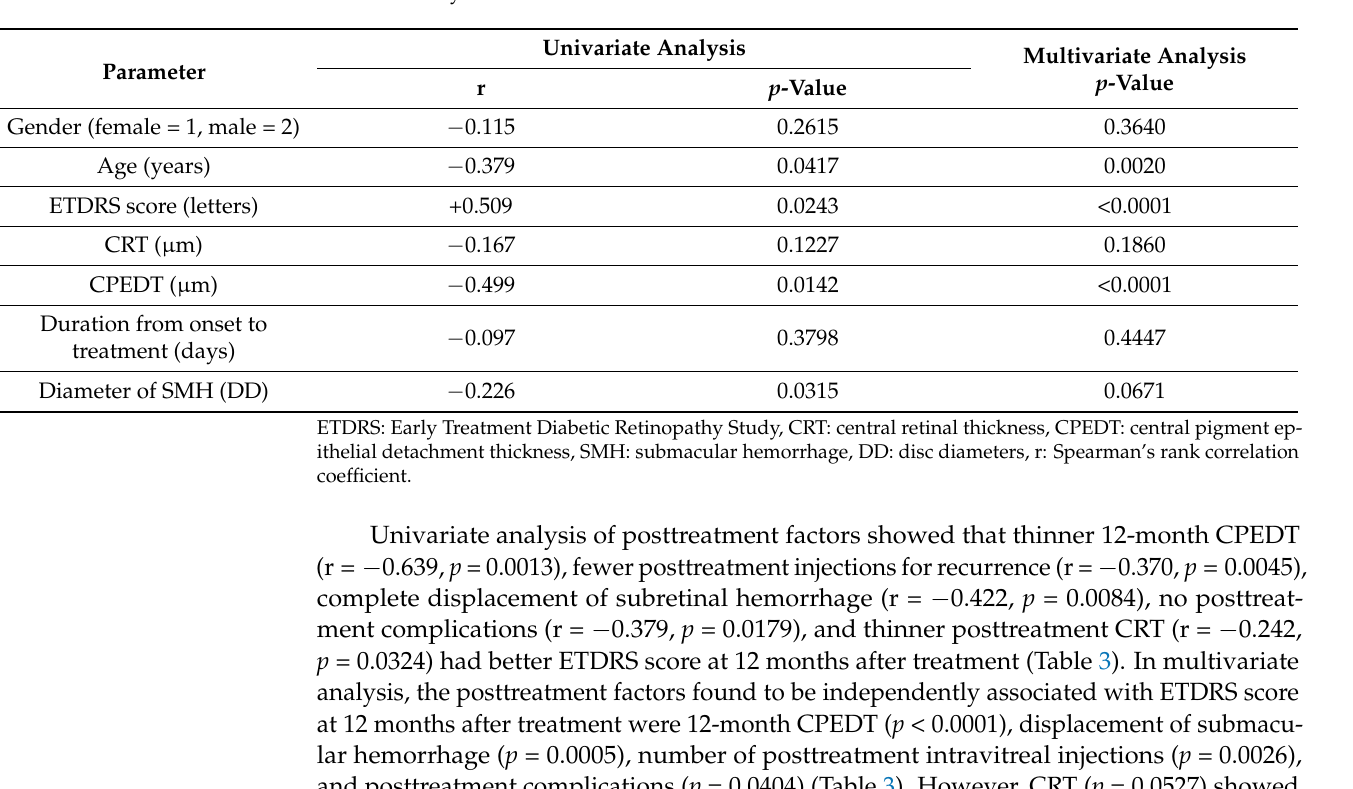
Table 2. Analysis of Pretreatment Factors Associated with 12-Month Posttreatment ETDRS Score.